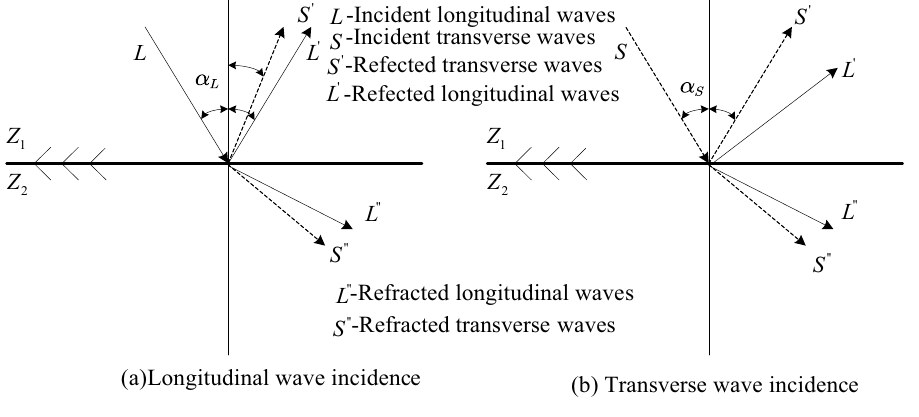
Figure 6. Mode conversion of reflected acoustic waves under different incident